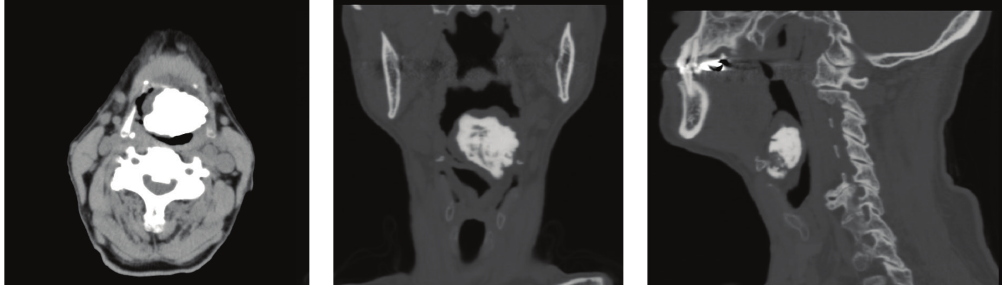
Figure 2: CT scan of the neck. A large osseous mass adjacent to the hyoid bone was observed.